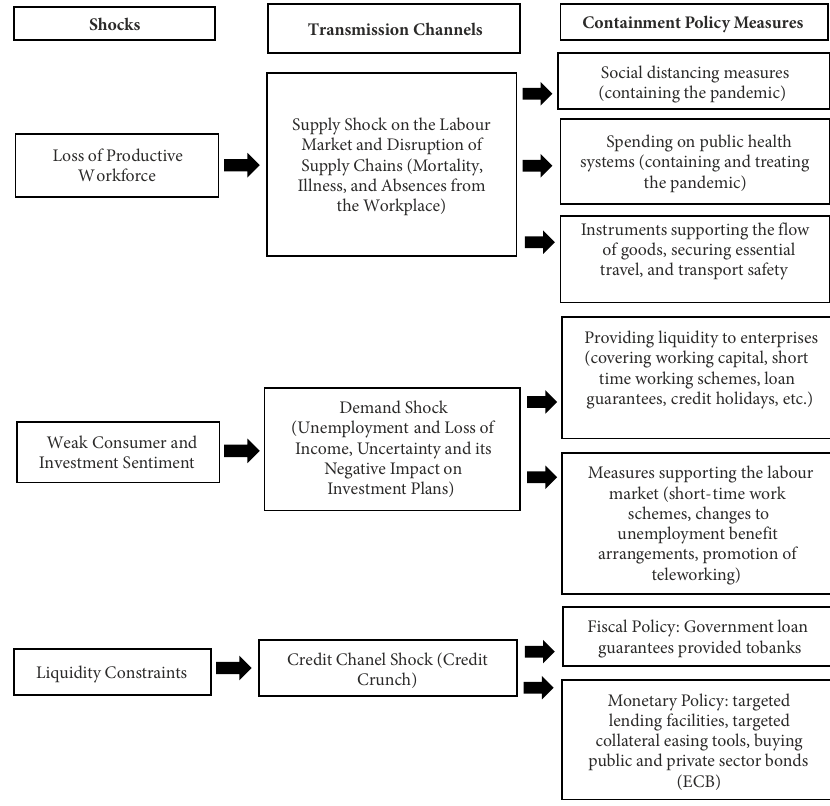
Figure 2. A Schematic Overview of Covid-19 Transmission Channels to the GDP Growth and Containment Policy Measures in the EU (source: own work based on European Commission, 2020; Boissay & Rungcharoenkitkul 2020; Gopinath, 2020; Lagarde,